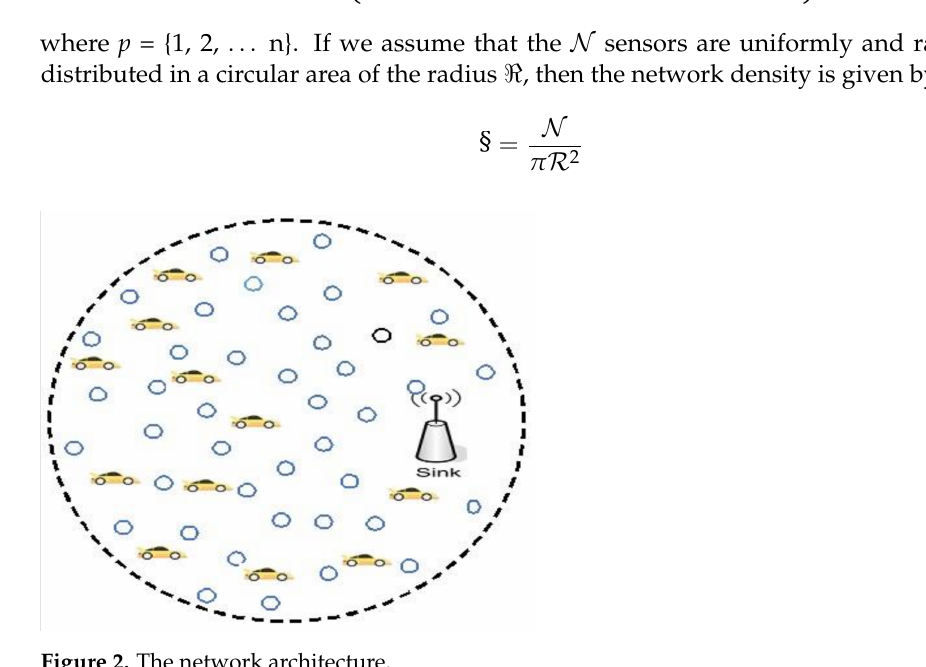
Table 1. Notations with their descriptions.